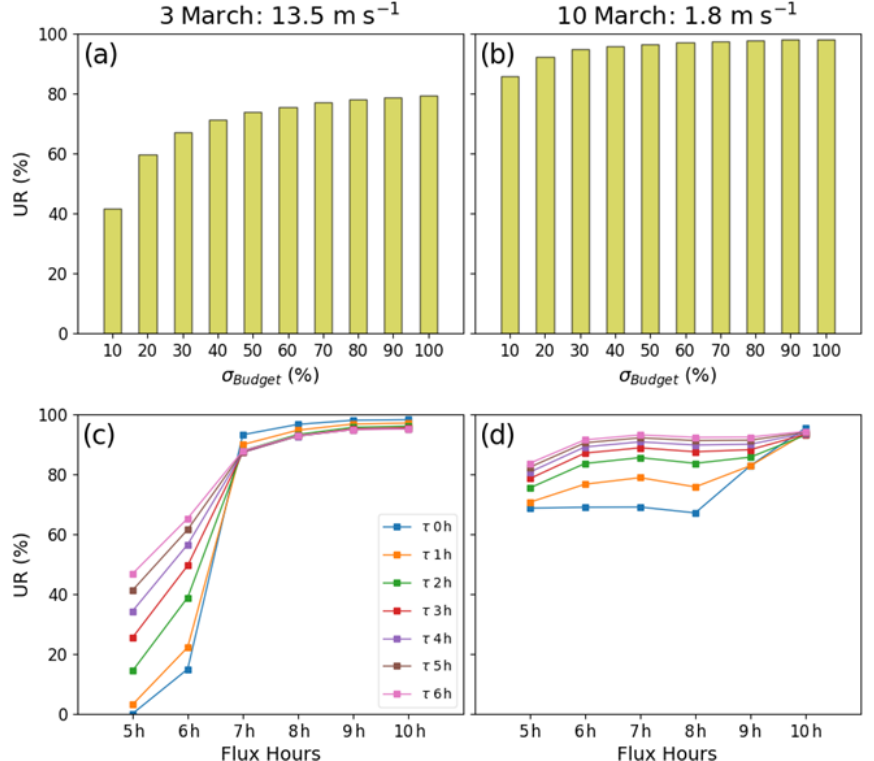
Figure 5. Uncertainty reductions (UR) as a function of the prior uncertainty ( x axis) for 6h budgets of the Paris emissions (a, b) . Correlations between the prior errors on hourly emissions have a temporal length of 3h (see Sect. 2.4). Panels (c) and (d) show the UR for the hourly emissions between 5 and 11h ( x axis) for several temporal lengths defining the correlations between prior errors on hourly emissions (colored dots), with “ τ 0h” referring to an absence of such correlations. Prior uncertainties on 6h budgets of Paris emissions are taken to be equal to 50% in panels (c) and (d) . Columns represent 2 different inversion days: 3 March 2016 (strong wind) and 10 March 2016 (low wind). All inversion results are computed with a retrieval resolution of 2km × 2km, a precision of 0.6ppm and a swath of